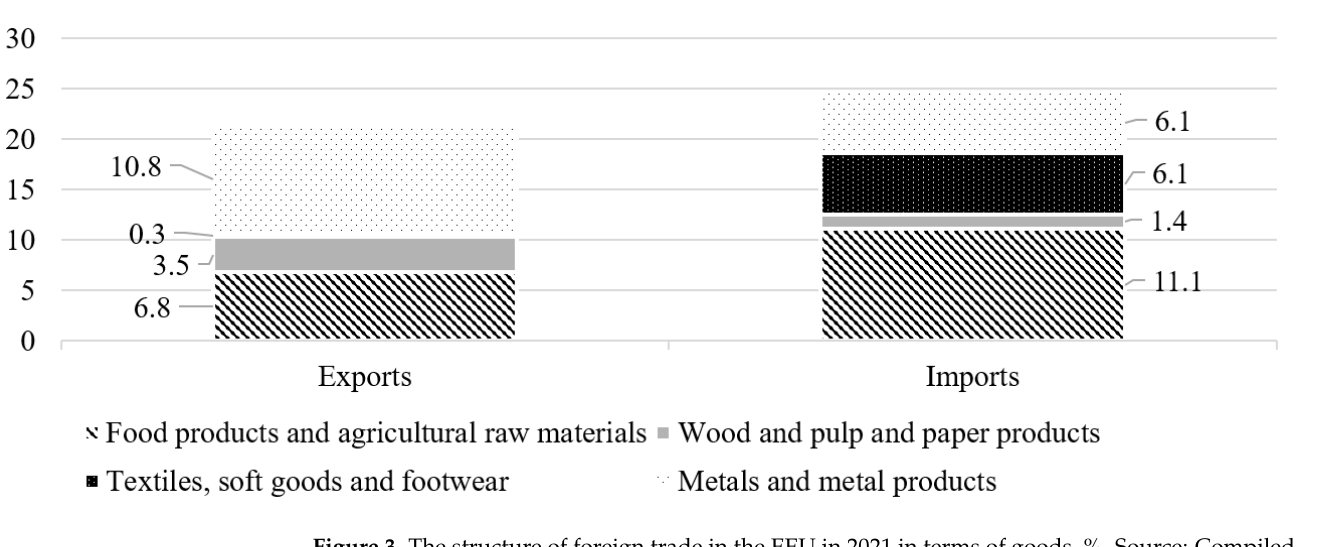
Figure 2. The structure of foreign trade in the EEU in 2021 in terms of groups of countries, billion US dollars. Source: compiled by the authors based on data from the Eurasian Economic Commission exports and 11.1% in the structure of imports. (2021b).